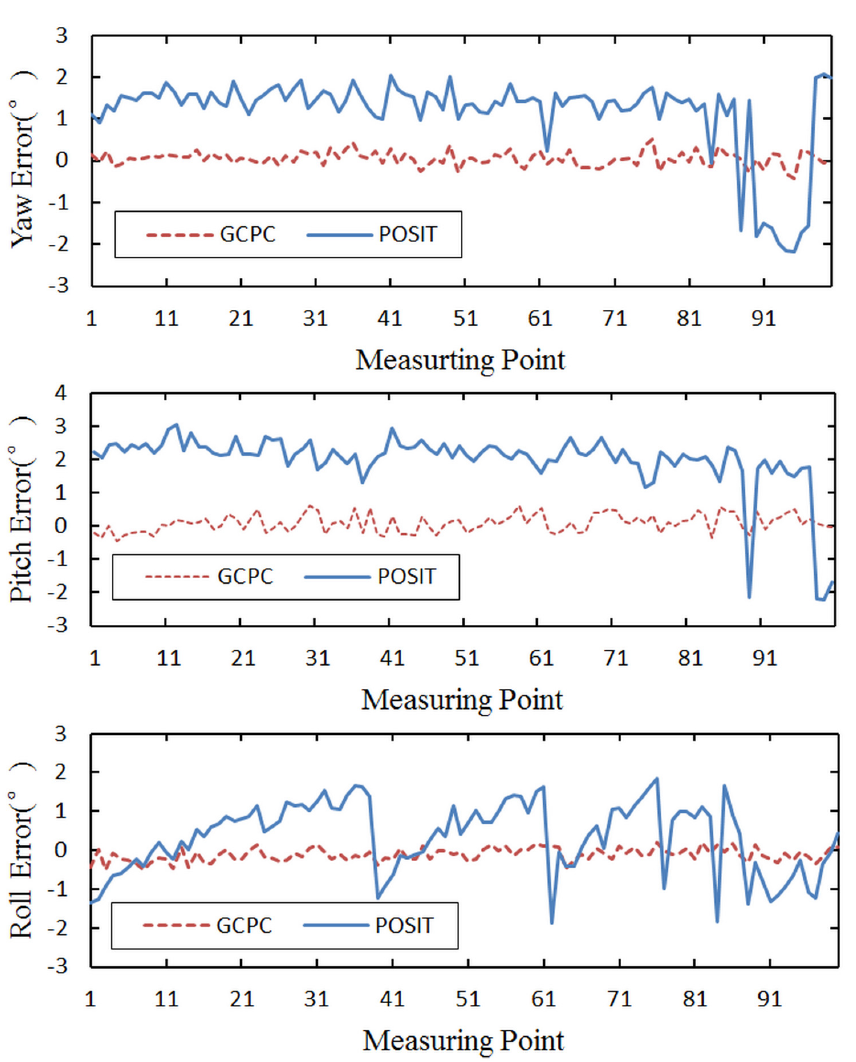
Fig 14. The accuracy comparison between GCPC and